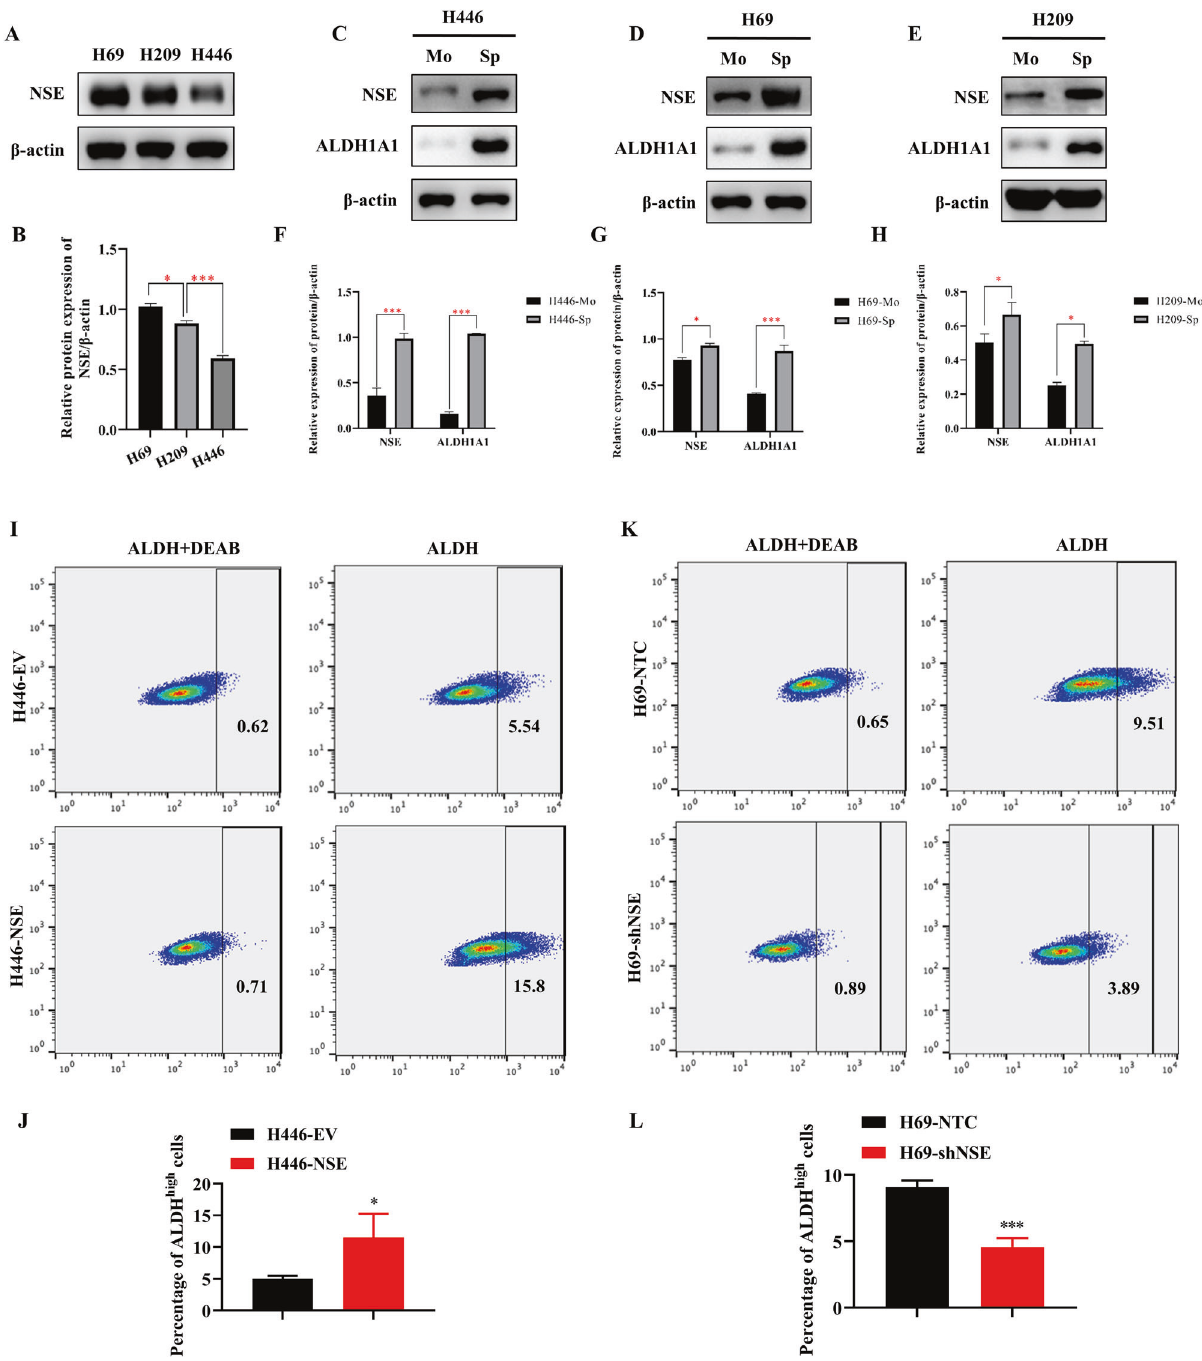
Fig. 1 NSE is highly expressed in sphere cells and regulates the percentage of CSCs. A Western blot detects the expression level of NSE in different SCLC cell lines, and the relative protein levels (NSE/ β -actin) were quanti fi ed as the column graph ( B ). C – E The expression levels of NSE and ALDH1A1 in spherical cells were signi fi cantly increased ( C : H446 cell; D : H69 cell; E : H209 cell). F – H All western blot images were quanti fi ed by the ImageJ software to estimate the relative protein expression (protein / β -actin) ( F : H446 cell; G : H69 cell; H : H209 cell). I NSE overexpression enriched the percentage of the ALDH high CSC population. NSE overexpression in H446 cells (H446-NSE), negative control cells (H446-EV). J The bar charts represent the proportion of the ALDH high CSC population. K Knockdown of NSE diminished the ALDH high CSC population in SCLC cells. They silenced NSE in H69 cells (H69-shNSE) negative control cells (H69-NTC). L The bar charts represent the percentage of the ALDH high CSC population. Results are shown as mean ± SD of independent experiments, and each experiment was repeated and rabbit anti-NBL1 polyclonal antibody (1:200; Af fi nity) overnight at used were Dylight488, goat anti-mouse IgG (H + L) (Earthox) and 4 °C. The sections were then incubated with secondary antibodies for 2 h Dylight649, and goat anti-rabbit IgG (H + L) (Earthox). Sections were at room temperature after thorough washing, followed by staining with mounted using an Antifade reagent (Applygen) for fl uorescence DAPI staining solution (Beyotime) for 15 min. The secondary antibodies microscopy.